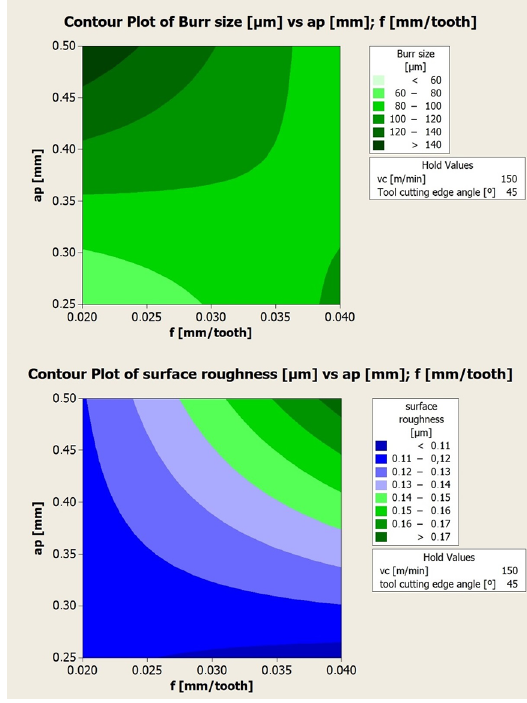
Figure 9. Contour plots for carbon fiber burrs and titanium surface roughness, (vc = 150 m/min)